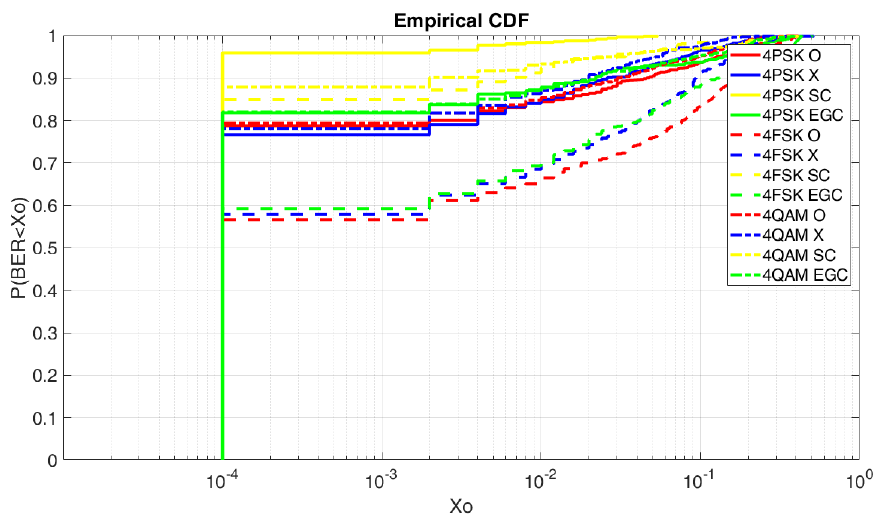
Figure 8. Bit error rate (BER) CDF order 4 modulations at 50 W.